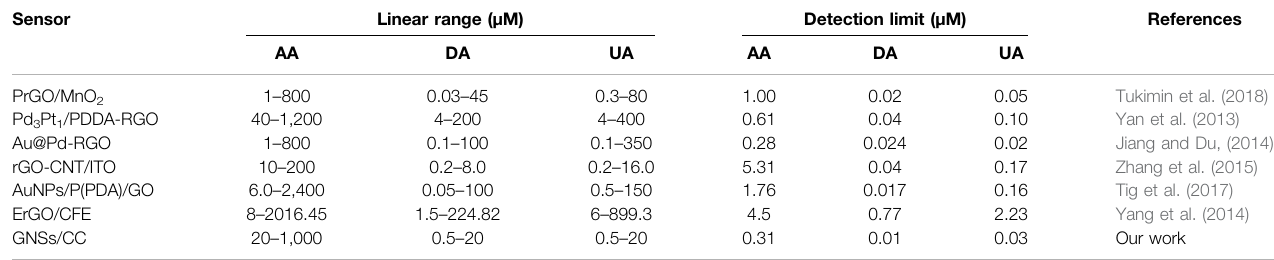
TABLE 2 | Performance comparison of sensors for small molecule detection.